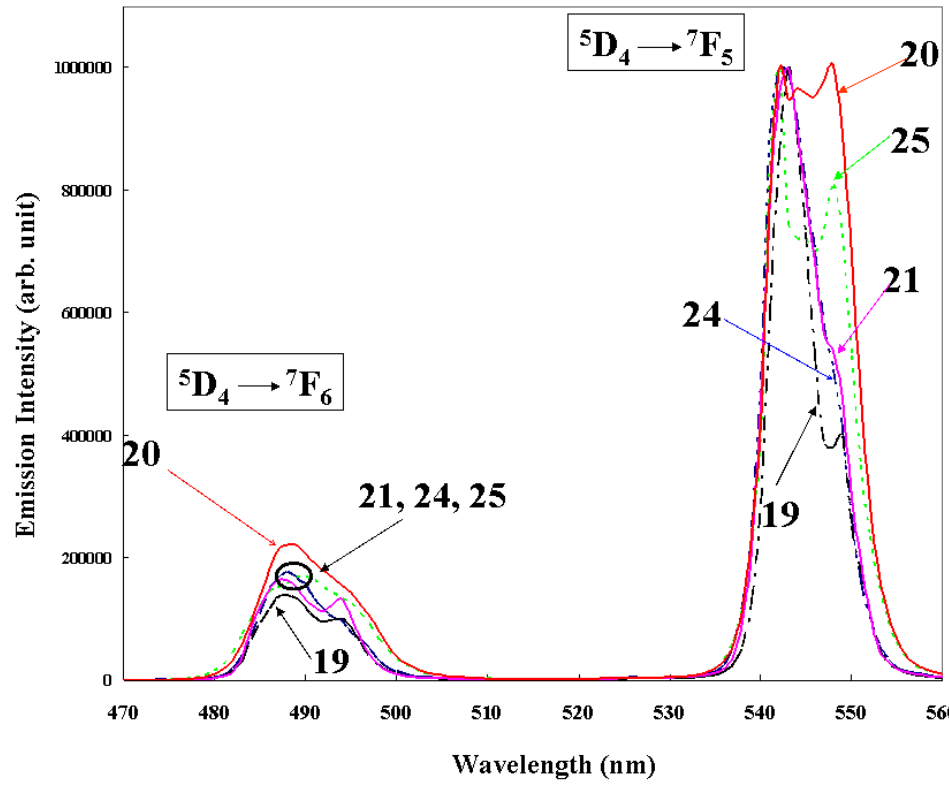
to 7 F ”, which corresponds to 4 5